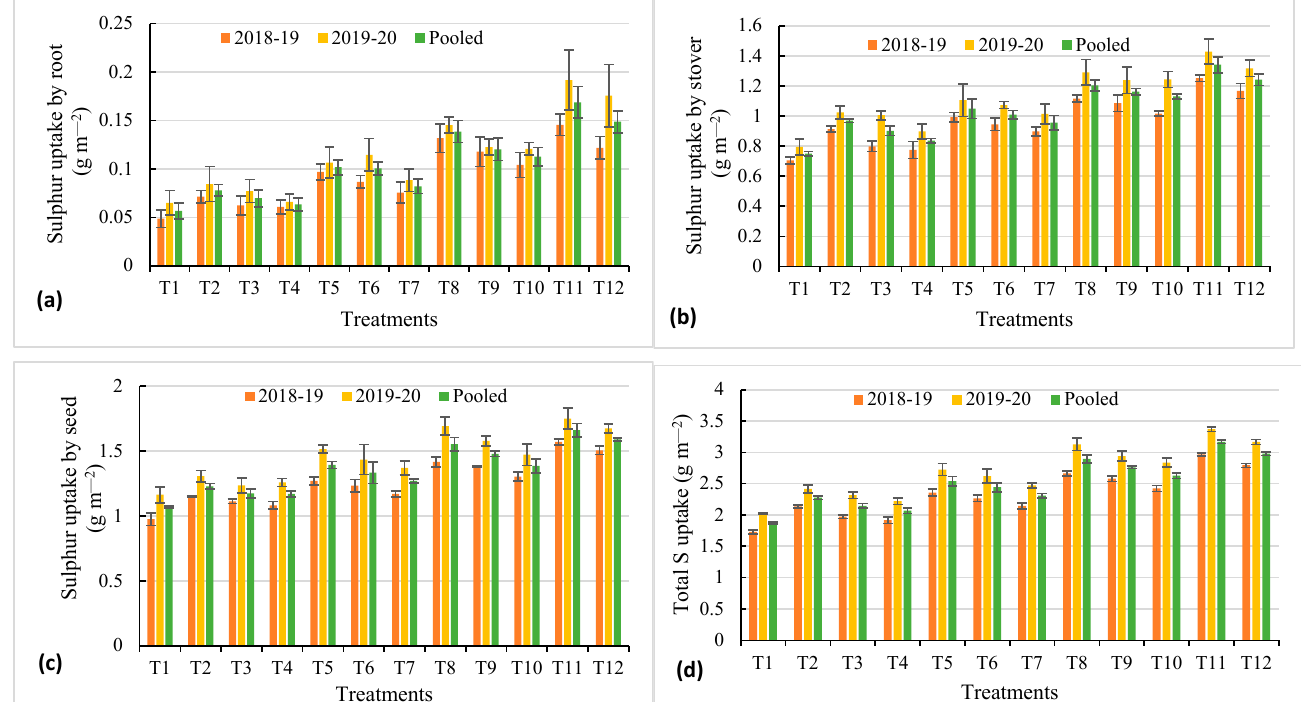
Figure 1. Sulphur uptake by root, stover, and seed as influenced by the seed biopriming and varied levels of S fertilization in mustard. ( a ) S uptake by root; ( b ) S uptake by stover; ( c ) S uptake by